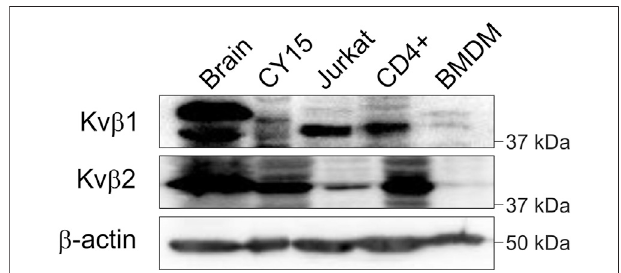
FIGURE1| Kv β 1andKv β 2expressioninthebrainandleukocytes.Total lysates from rat brain and different leukocytes were immunoblotted against Kv β 1 and Kv β 2. Mouse dendritic CY15, human Jurkat T cells, human CD4+ lymphocytes,andmurineBMDMsampleswereobtainedandprocessed as described in the methods. Top panel, Kv β 1; middle panel, Kv β 2; bottom panel, β -actin as a control. Note that representative western blots are shown only for qualitative purposes. No comparison among groups due to species, cell type and sample processing is